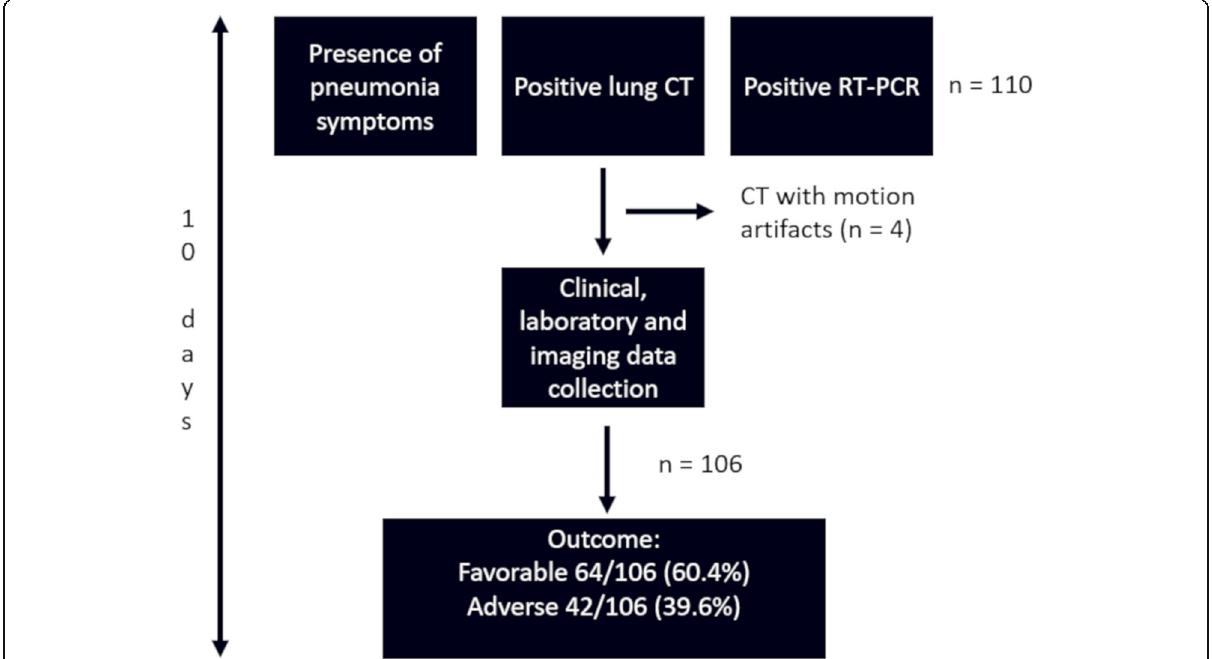
Fig. 1 Flow chart diagram of the study design. CT, Computed tomography; RT-PCR, Reverse transcription-polymerase chain reaction